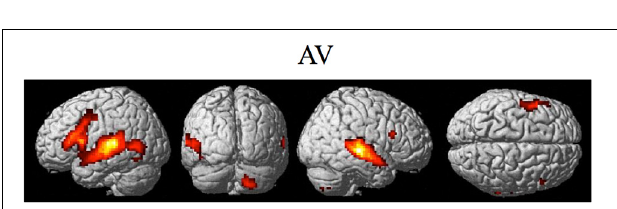
FIGURE 3 | Significant brain activity for the VO condition thresholded at pFDR < 0.05 corrected. Activity was present in the left PMvi/Broca’s, left PMvs/PMd, and left and right MT/V5 visual motion processing area.